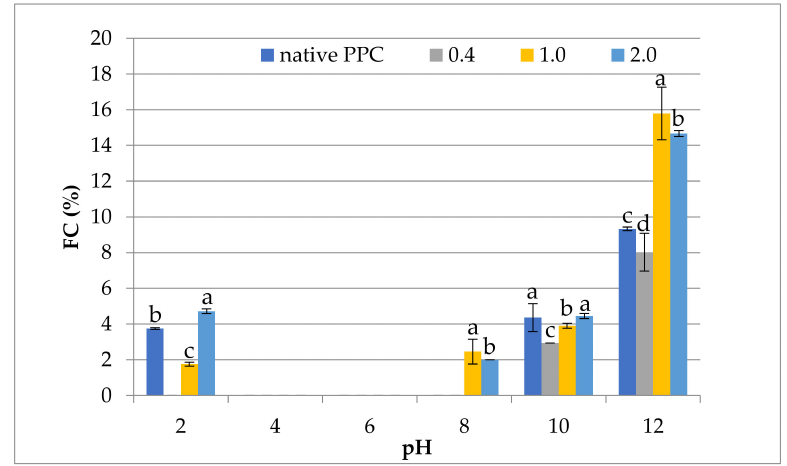
Figure 4. Effect of anhydride-to-protein ratio on foam capacity (FC) at different pH of native and acetylated PPC. a,b,c —the same letters within the same pH were not significantly different; PPC— pumpkin protein concentrate; 0.4, 1.0, 2.0—pumpkin protein preparations after acetylation conducted with different concentrations of acetic anhydride (mL/g).